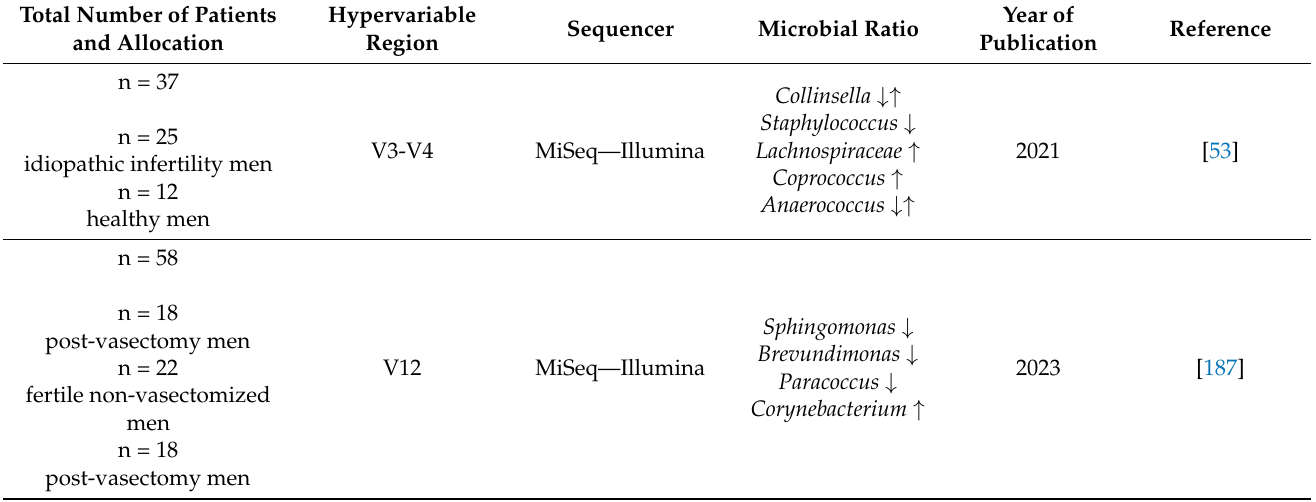
Table 5. Leading human semen microbiota studies based on the allocation of patients and platform used for sequencing with the microbial region and oscillations within communities observed in human